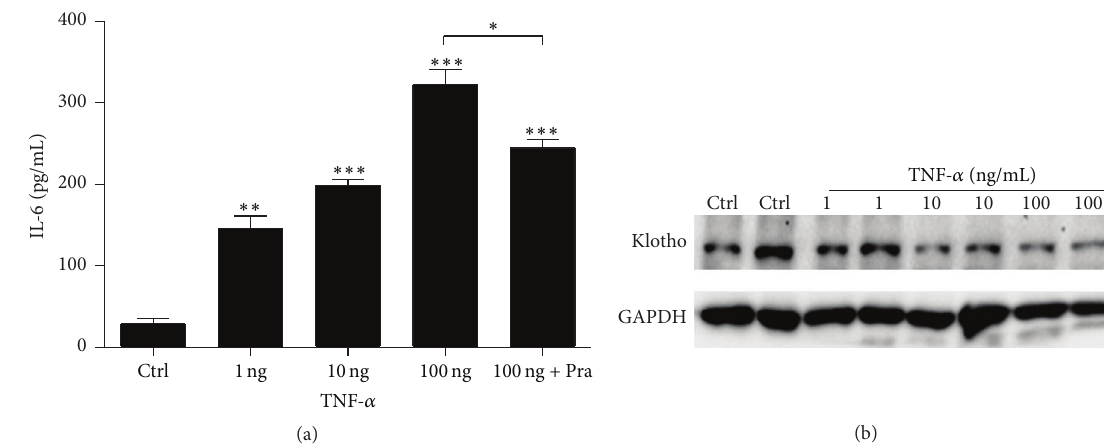
Figure 3: Pravastatin suppressed IL-6 production in HUVECs following TNF- 𝛼 administration. (a) ELLISA assay of IL-6 in medium. (b) Western blotting analysis of klotho in HUVECs following TNF- 𝛼 treatment. The values represent the means ± SDs ( 𝑛 = 4 in each group). ∗ 𝑝 < 0.05 versus TNF- 𝛼 100ng group. ∗∗ 𝑝 < 0.01 versus Ctrl group. ∗∗∗ 𝑝 < 0.001 versus Ctrl group.